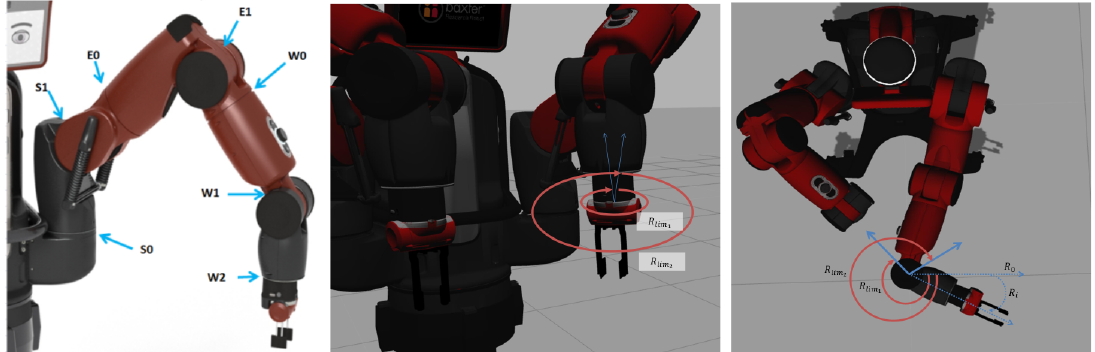
Figure 8. Configuration of the wrist joints: ( left ) Baxter joints; ( center ) standard configuration using W2 for Z-axis twist; ( right ) our configuration using W1 for Z-axis